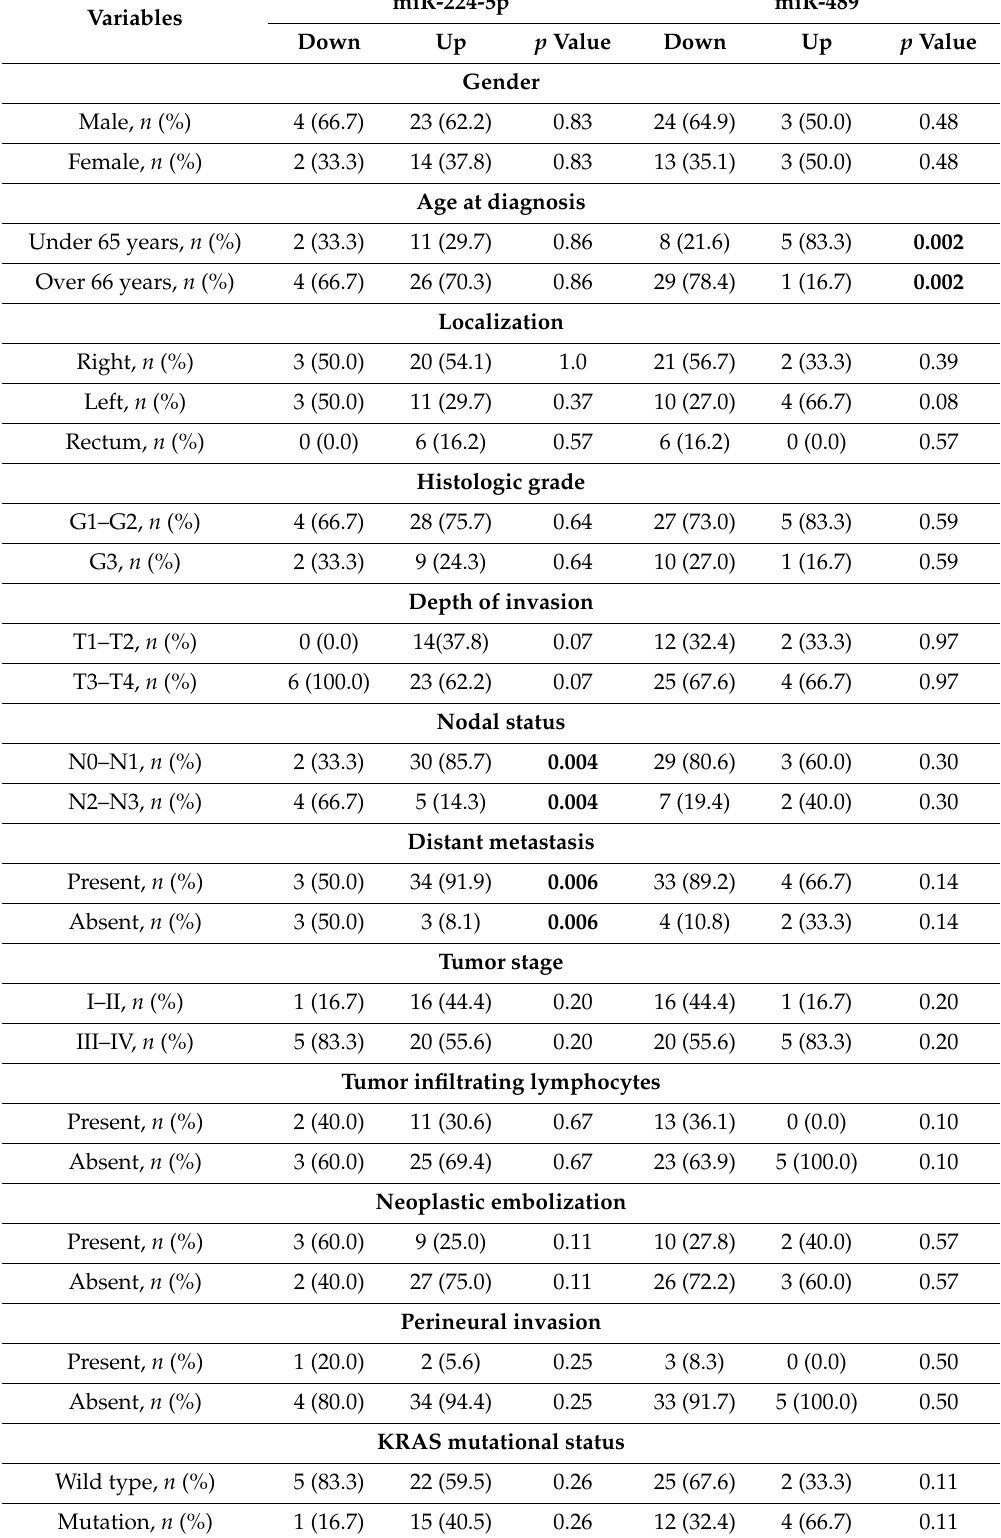
Table 4. Clinic-pathological and molecular data of CRC patients according to miR-224-5p and miR-489 expression level